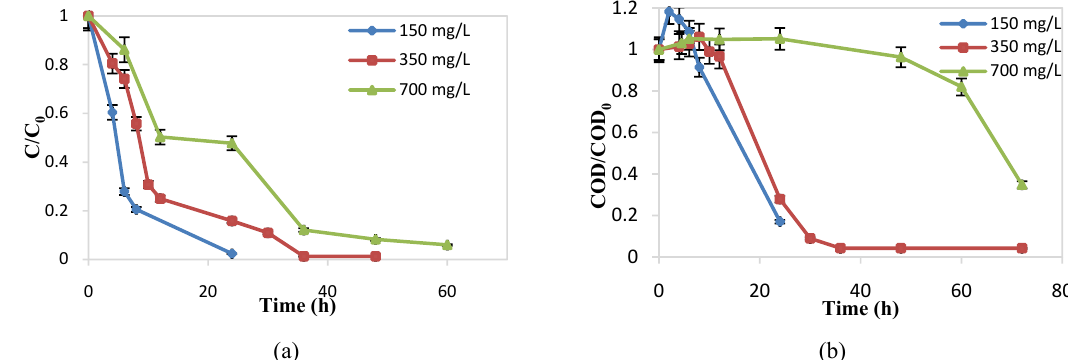
Fig1. (a) SDBS concentration to initial SDBS concentration ratio vs. time (b) COD/COD 0 vs. time in various initial SDBS concentrations ([TiO 2 ] =0.5 mg/L, pH=8)